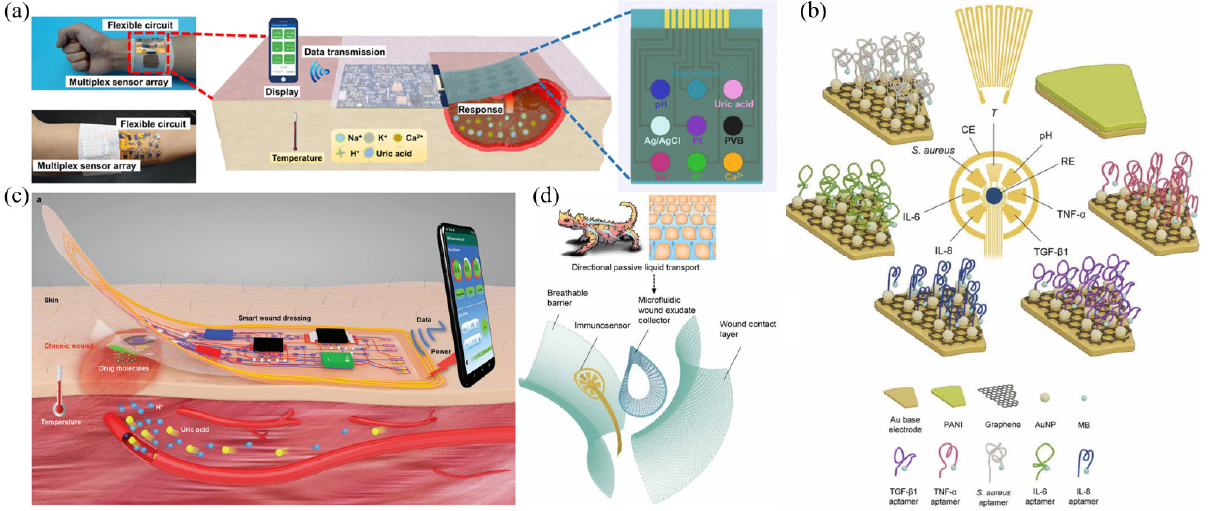
Figure 4. Flexible wearable sensors for wound multiparameter detection. ( a ) Schematic diagram of a wearable flexible sensor for detecting Na + , K + , Ca 2+ , pH, uric acid, and temperature in wounds [82]. Copyright (2021) American Chemical Society. ( b ) An integrated electrochemical sensor detect inflammatory mediators (including tumor necrosis factor- α , interleukin-6, interleukin-8, and transforming growth factor- β 1), microbial burden ( S. aureus ), and physicochemical parameters (temperature and pH) [83]. Copyright (2021) Amer Assoc Advancement Science. ( c ) Smart dressing for pH, uric acid, and temperature detection in wounds and electronically controlled release of drug molecules for treatment [25]. Copyright (2021) John Wiley and Sons. ( d ) Sensor module for multiparameter wound detection, including a wound contact layer, microfluidic wound exudate collector based on the Texas lizard skin bionic principle, immunosensor, and breathable barrier [83]. Copyright (2021) Amer Assoc Advancement Science.